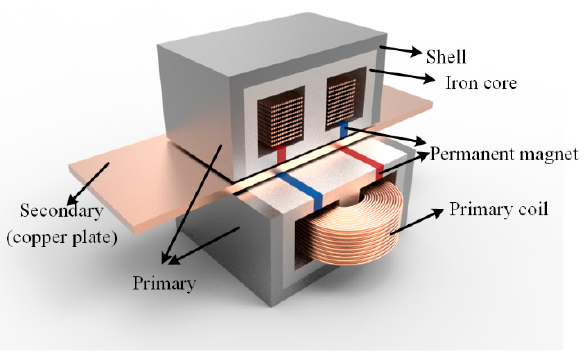
Figure 22. Dual-sided hybrid excitation eddy current damper. Reprinted with permission from ref. ref. [108]. Copyright 2020 IEEE.